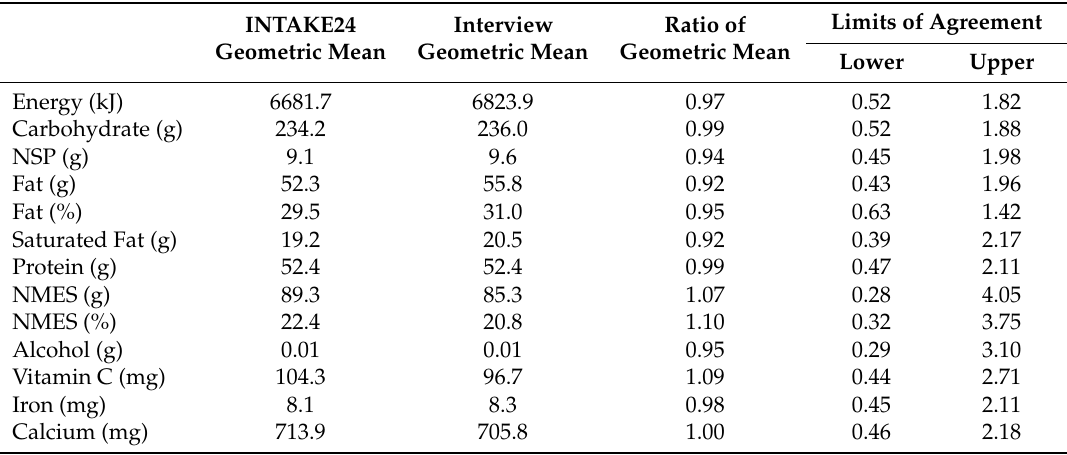
Table 2. Agreement of intakes reported using INTAKE24 with interviewer-led recalls for 11–16 years old (participants completing any number of days, n = 52).